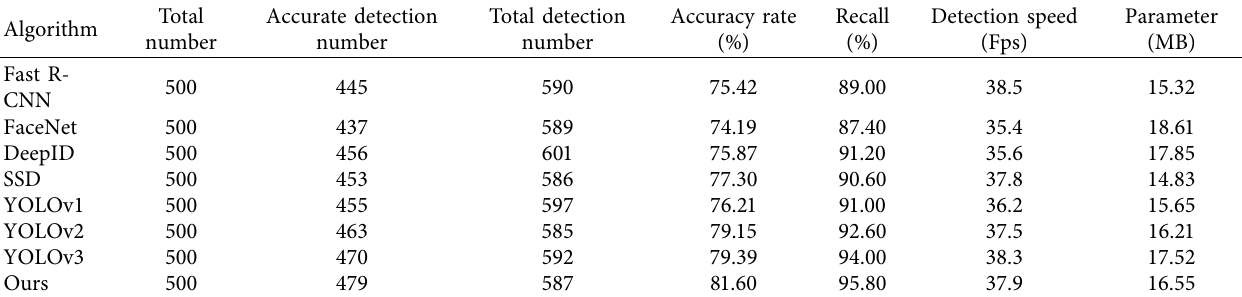
Table 4: Test results in COCO dataset.